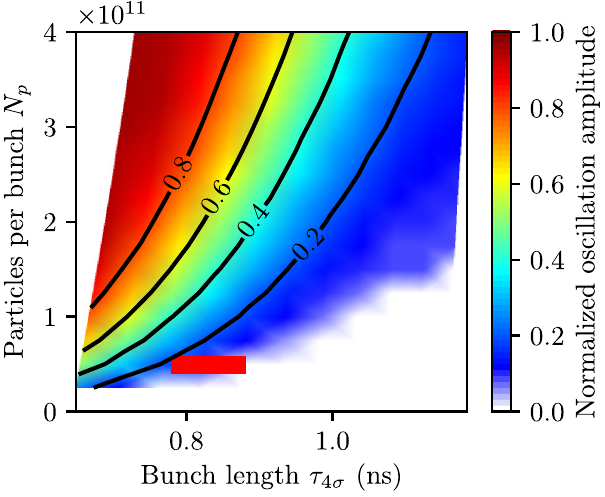
4 GHz (left) and f 8 GHz r ¼ r ¼